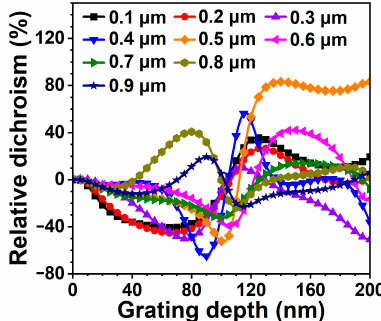
Figure 2. Dependence of relative dichroism ( RD ) on grating depth with the grating period as a parameter. The duty cycle is 0.5.